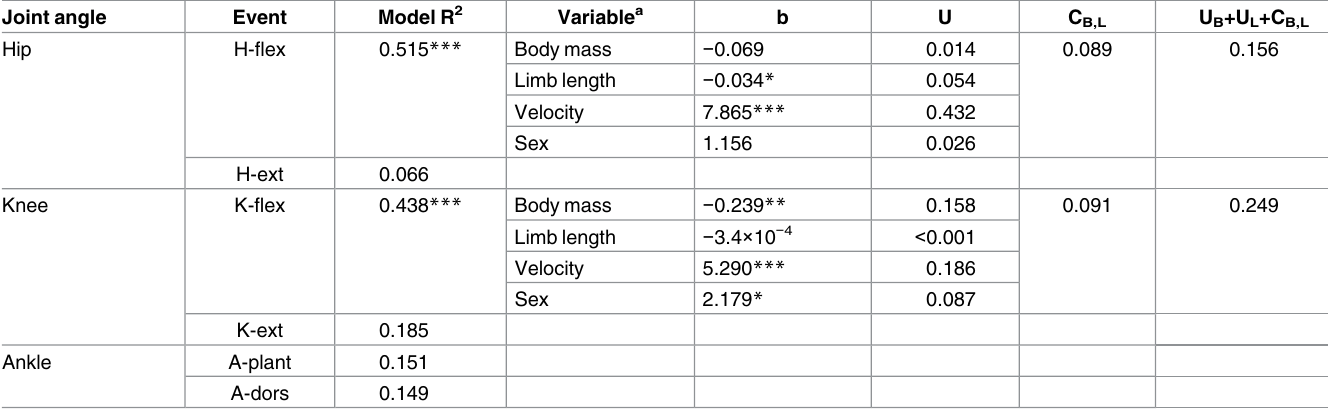
Table 7. Effect of body mass, lower limb length, velocity, and sex on joint flexion angles at selectedgait events using general linear